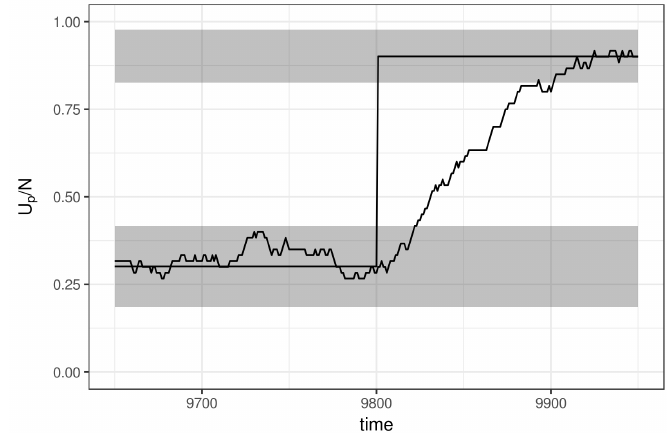
Figure 5. The tracked rating follows the true value of a simulated player that showed a jump in ability at iteration